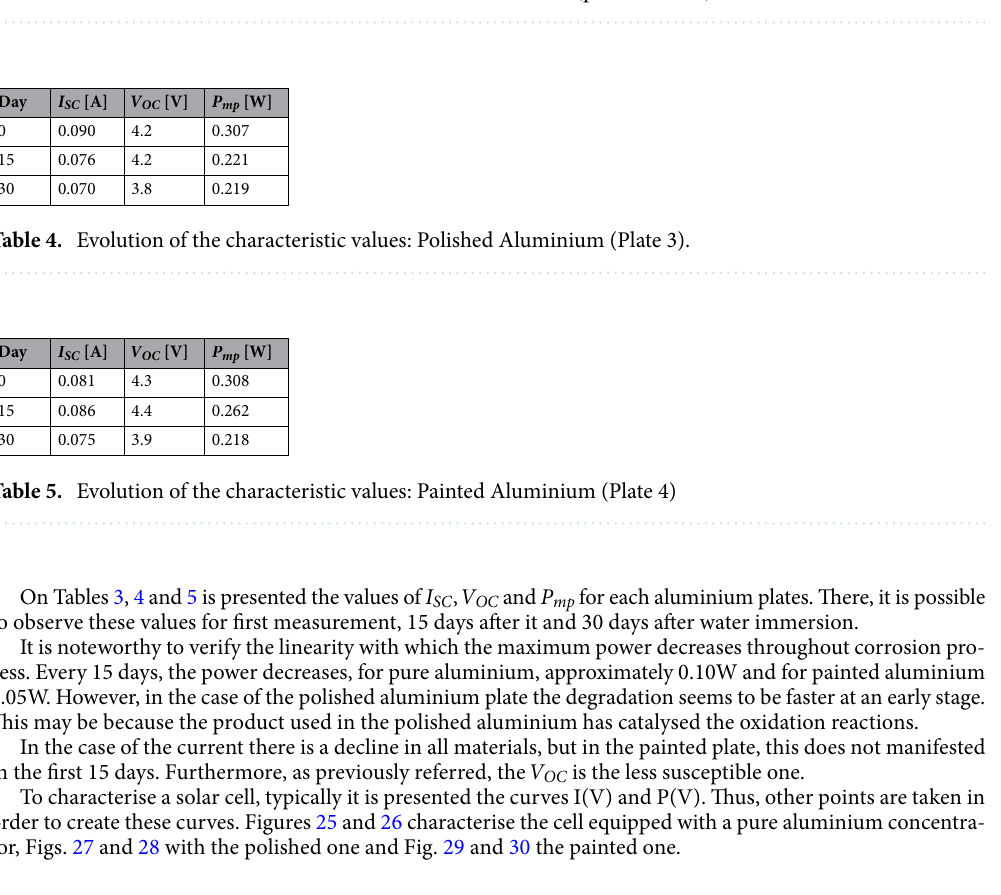
Table 3. Evolution of the characteristic values: Pure Aluminium (plates 1 and 2).